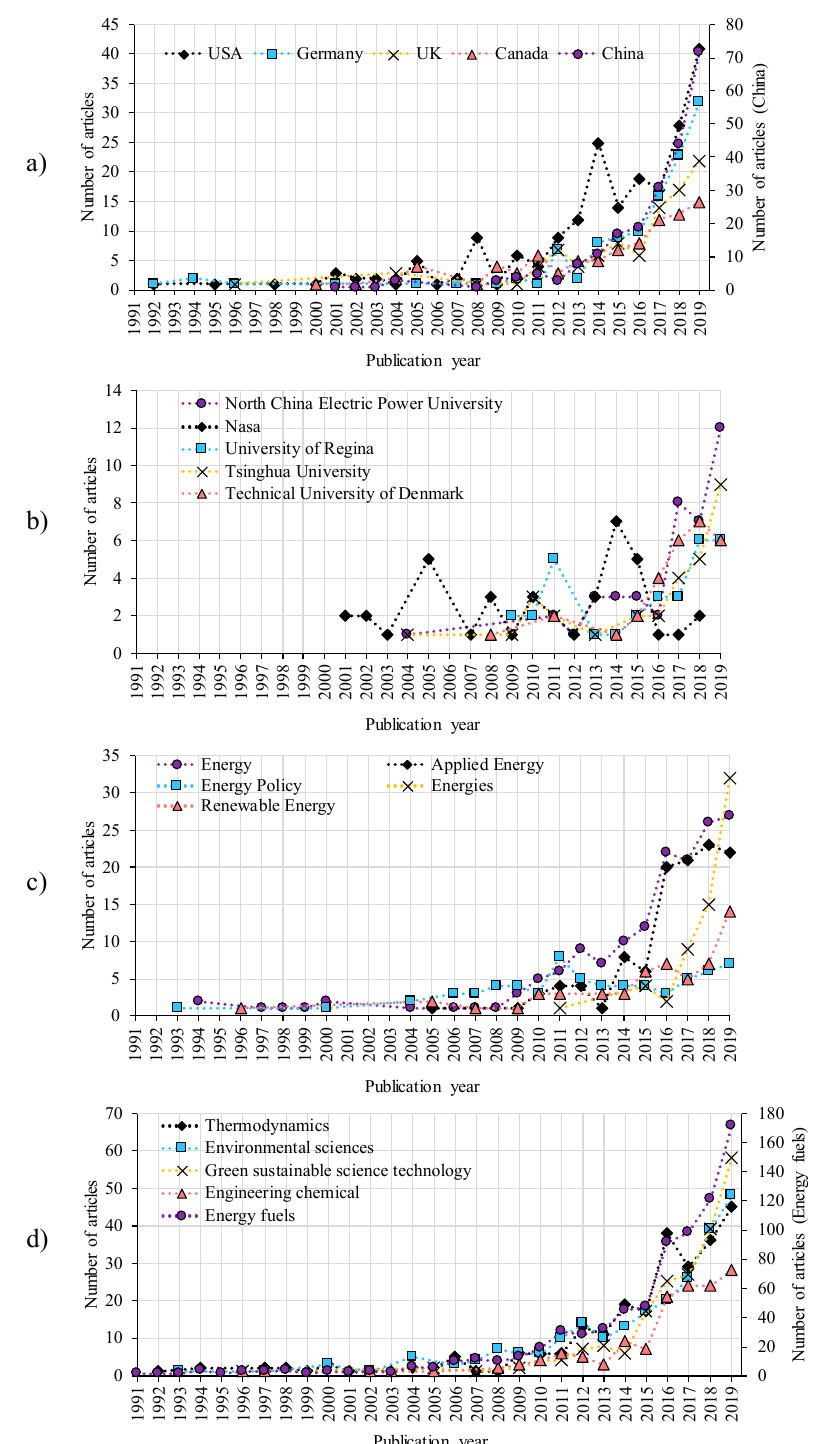
Figure 2. Annual development of publications of the top five most productive countries ( a ), institutes ( b ), journals ( c ) and subjects ( d ). For reasons of clarity, zero values are not